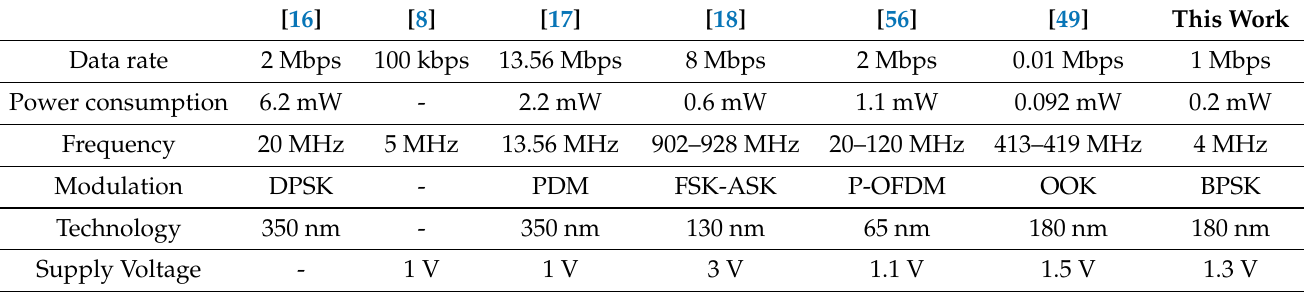
Table 5. Comparison with other medical implant receivers. (P-OFDM—Pseudo orthogonal frequency- division